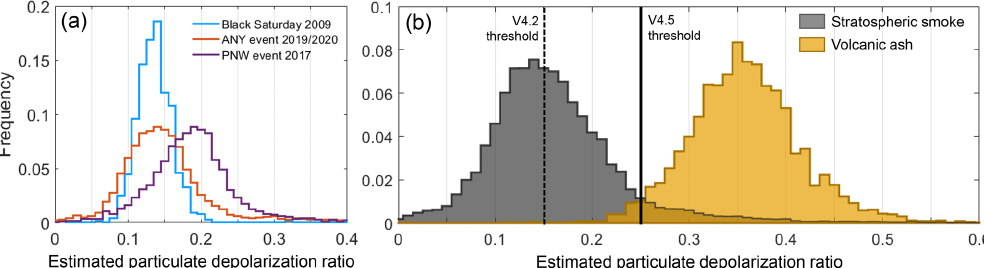
Figure 10. Frequency distributions of estimated particulate depolarization ratio ( δ est p ) for layers identified in Table 1, comparing three major stratospheric smoke events (a) and all stratospheric smoke events (b) to all volcanic ash events. Only layers with γ (cid:48)